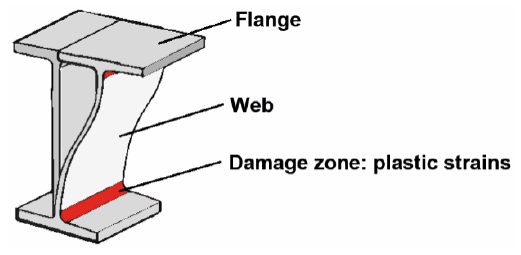
Figure 2. Deformation of an I ‐ section segment of a WPD.